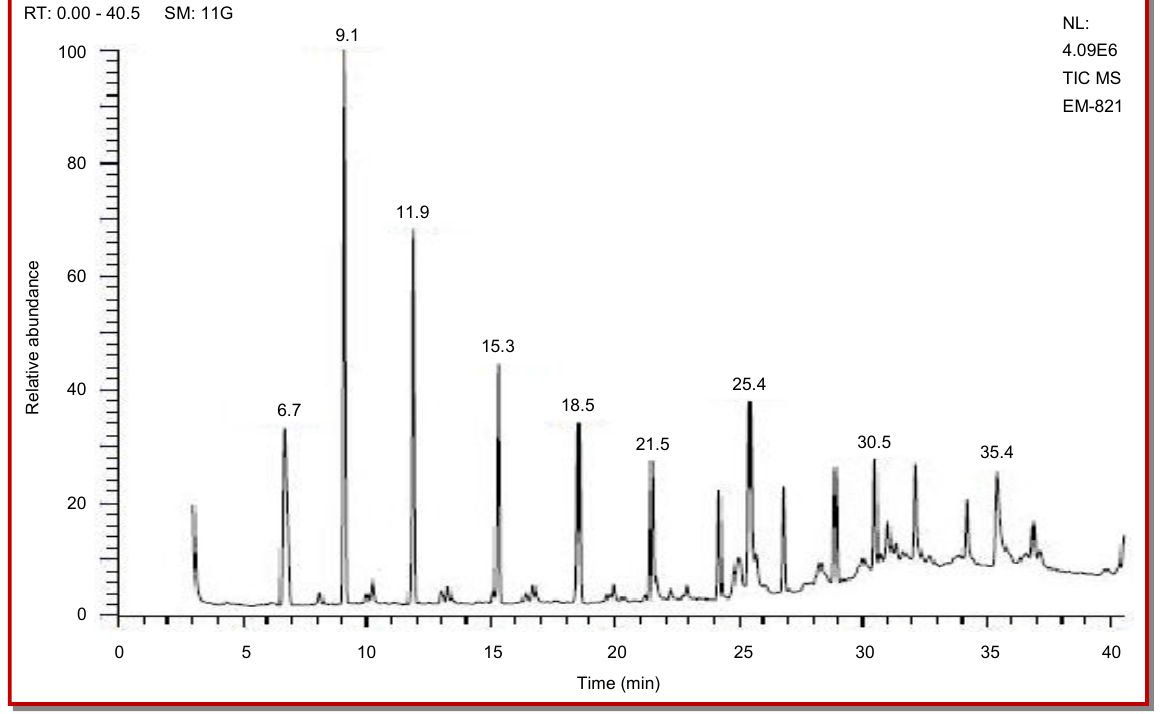
Figure 4: GC-MS chromatogram of TLC separated band 5 of methanol extract of C.